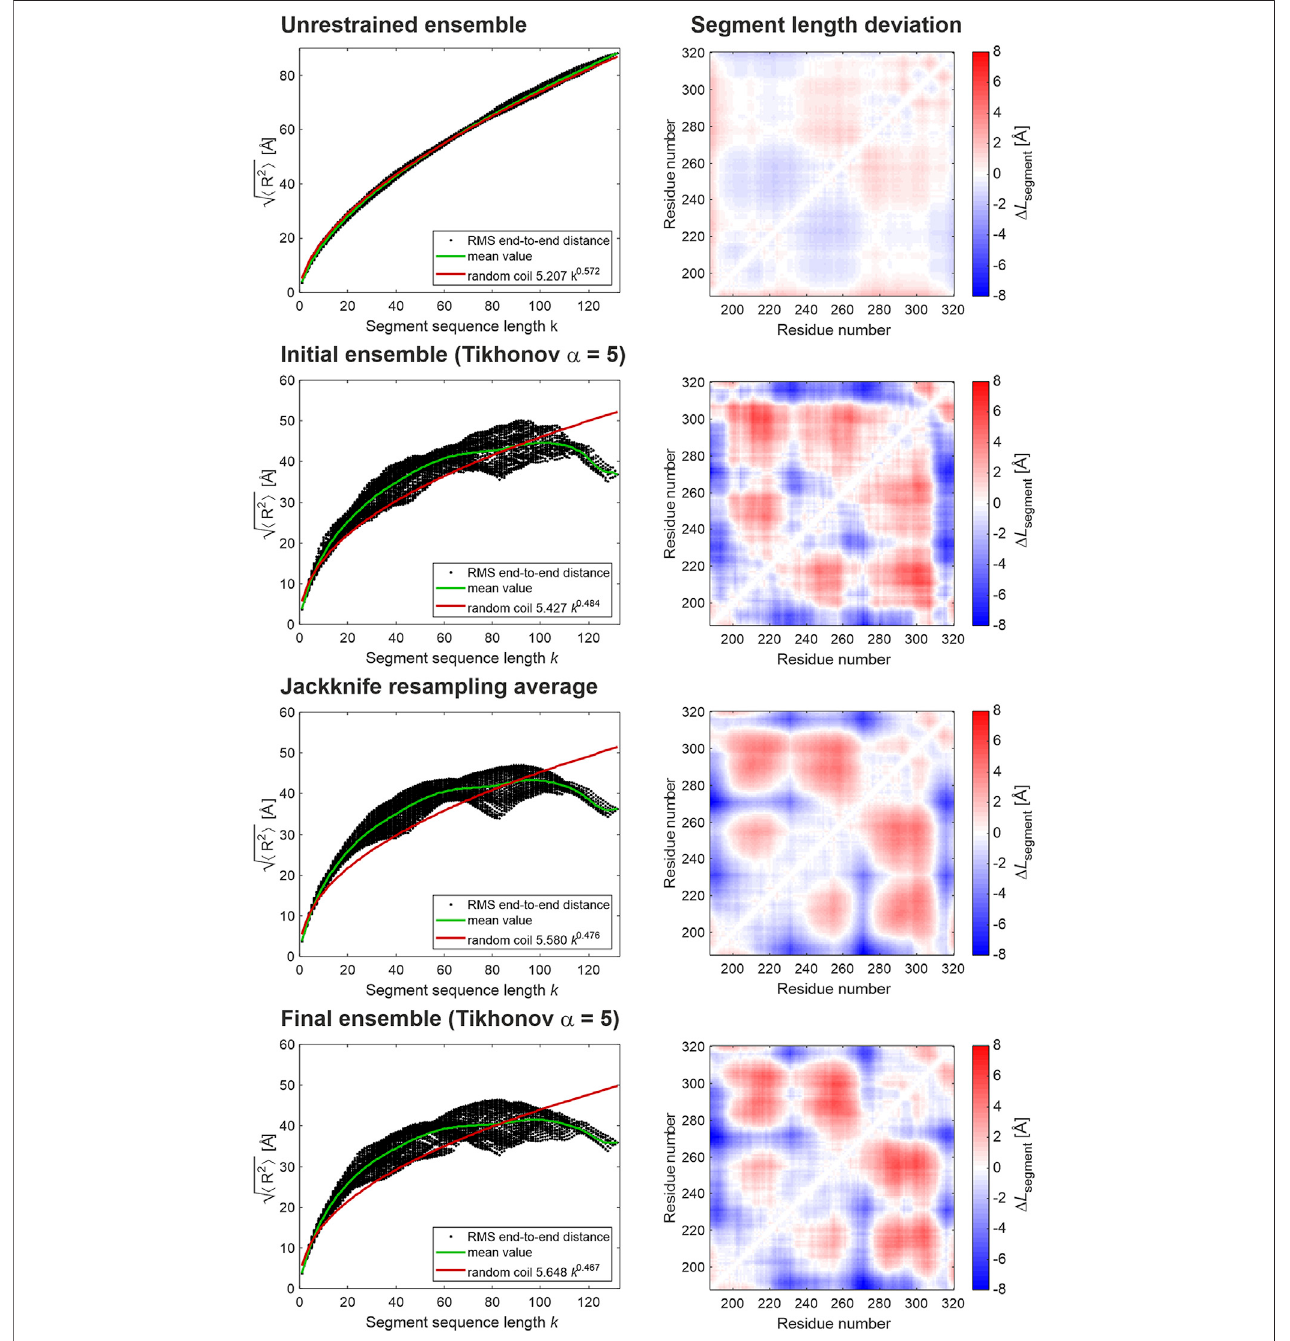
FIGURE6| EnsembleanalysisfortheLCDofhnRNPA1.TheleftcolumnshowsrootmeansquareCA-CAdistancesforallpossiblesegmentsoftheLCD(residues 188 – 320) as a function of segment sequence length (black dots), their mean values per segment sequence length (green line), and a random coil fi t (red line). The right column shows the deviation of the RMS CA-CA distances from the mean value for this segment sequence length (green line in the left column). Red hues correspond to segments more extended than the average and blue hues to segments more compact than the average.